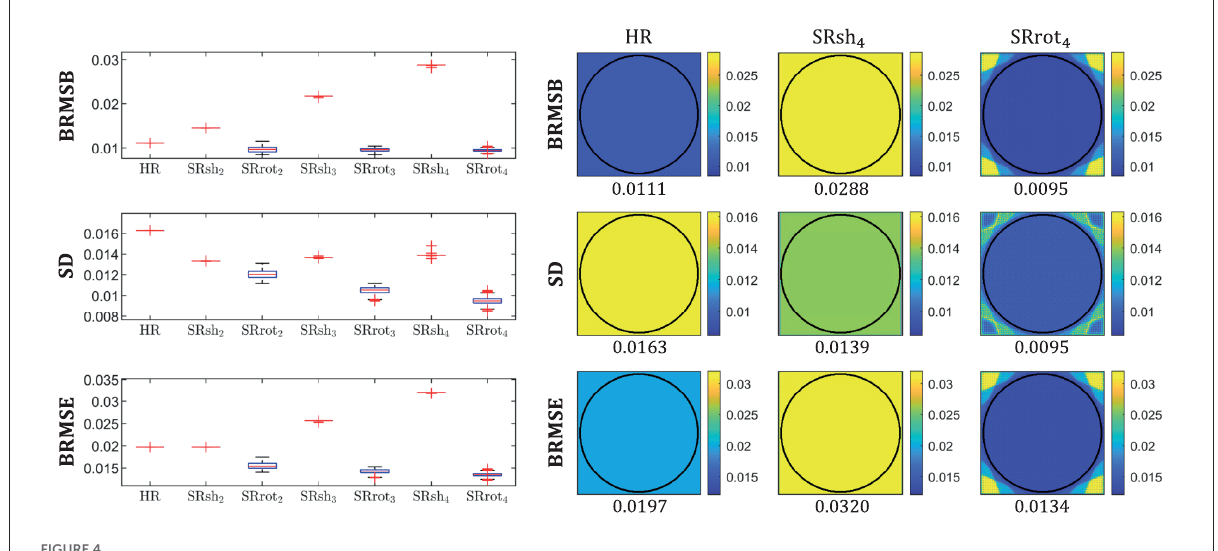
FIGURE4 Boxplots of BRMSE, SD, and BRMSB computed for each protocol inside an ROI (left) and the respective parametric maps (right) for the protocols HR, SRrot 4 , and SRsh 4 . For each box, the central mark indicates the median, and the bottom and top edges of the box indicate the 25th and 75th percentiles, respectively, and the outliers are plotted individually using the “+” marker symbol (MATLAB, 2020). Each box has a sample size of 35,629 voxels. For each map, the median value computed inside an ROI is reported. The ROI was defined as the part of the field of view common to all the acquired images of all the acquisition protocols, which corresponds with the area inside the circle plotted in the